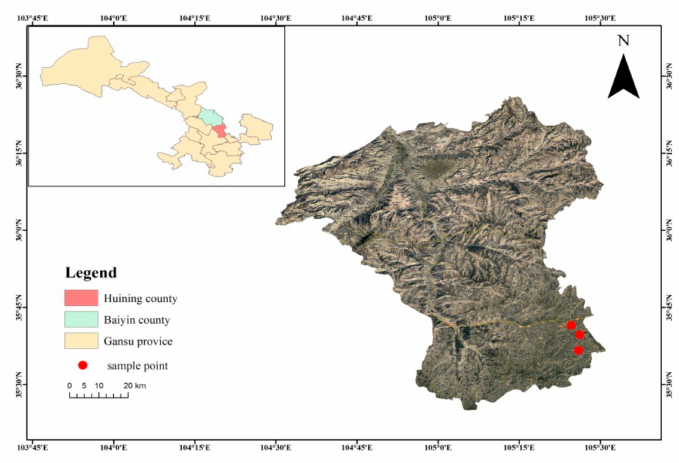
Figure 1. Location of the three experimental blocks in Huining County, Gansu Province,